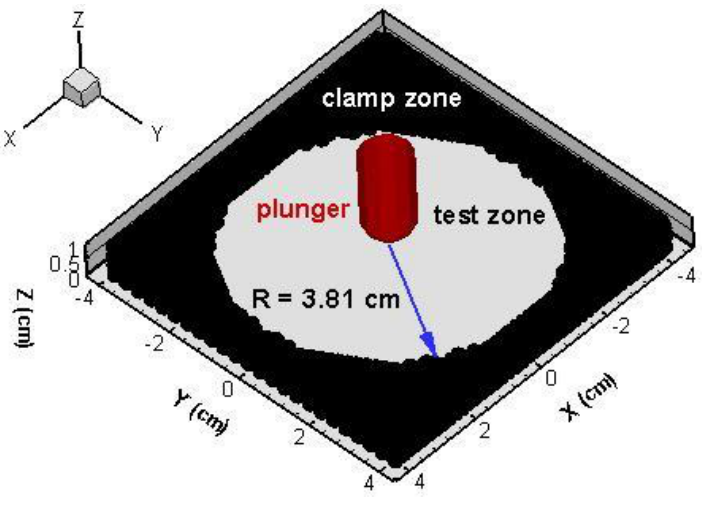
Figure 12. Setup of specimen for punch-shear test of vinyl ester plate.